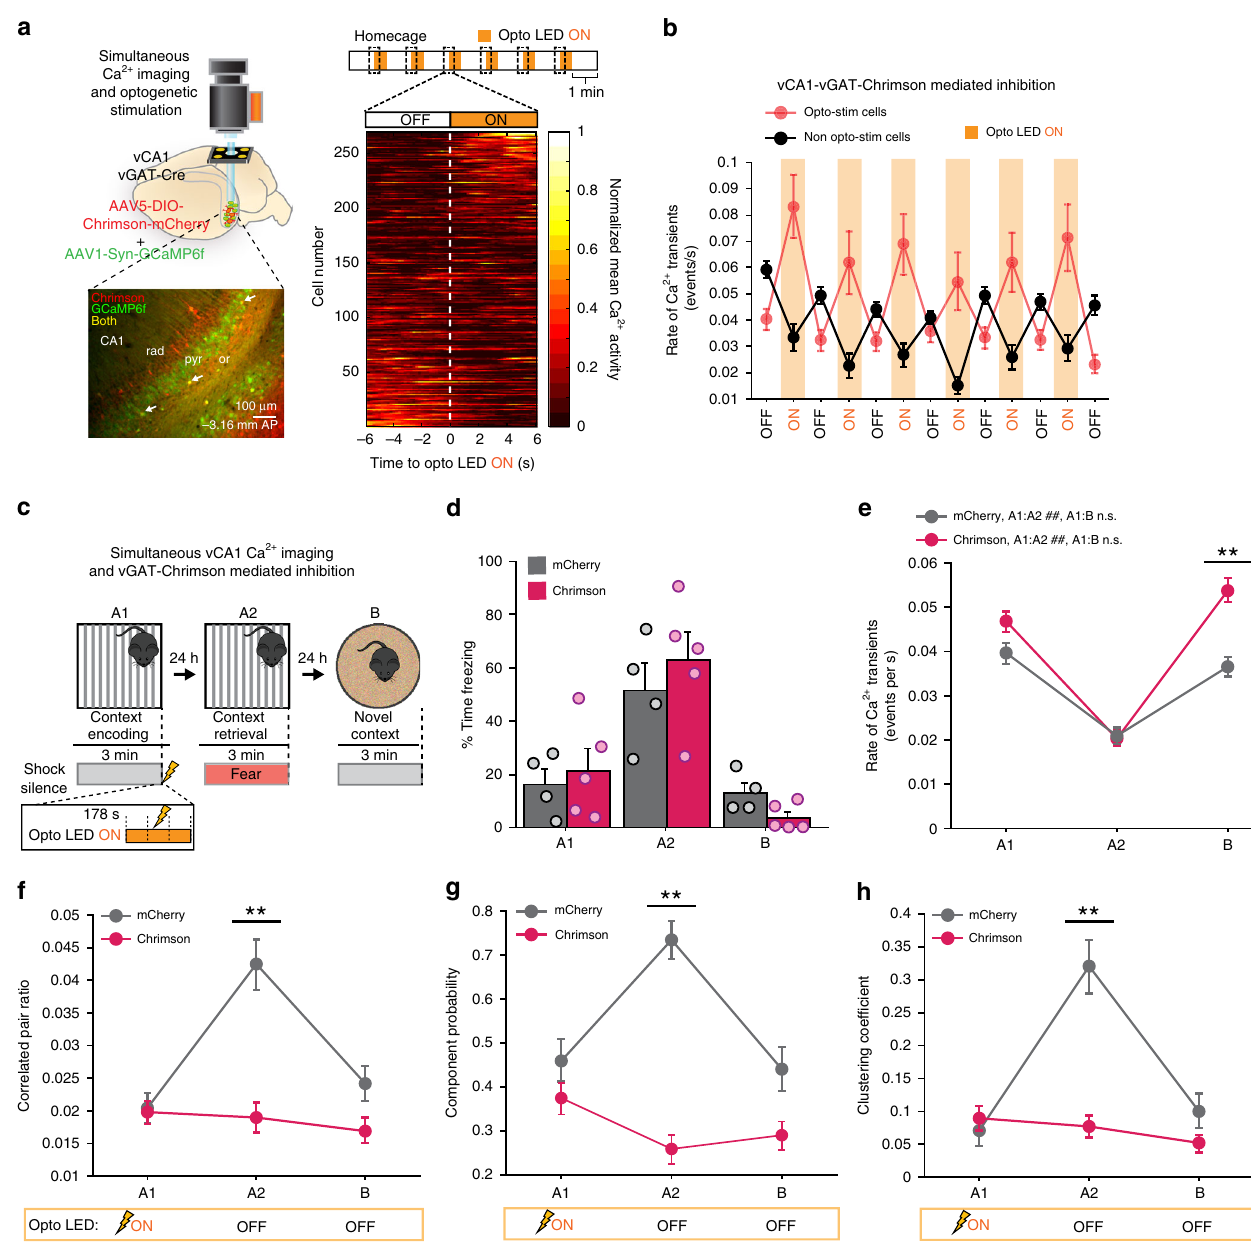
Fig. 4 vCA1 shock activity is necessary for correlated activity during memory retrieval. a Experimental design, simultaneous vCA1 Ca 2 + imaging and unilateral optogenetics. Top left: DIO-Chrimson and Syn-GCaMP6f were co-injected into vCA1 in vGAT-Cre mice to selectively express Chrimson in vGAT interneurons and GCaMP6f in all neurons. GCaMP6f was excited by a blue LED (455 nm). Chrimson was excited by an amber LED (590 nm). Bottom left: Representative image of vCA1 with co-expression of Chrimson (red), GCaMP6f (green), and cells expressing both (yellow) indicated by white arrow. Right: Heat map of Ca 2 + activity 6 s before and after turning on the optoLED (average of six pulses in homecage, cells sorted by magnitude of change ON – OFF). The main effect of this experiment was replicated in an independent dataset within the lab. b Rate of Ca 2 + transients in homecage during optoLED 6-s pulses ON in opto-stim (red) and non-opto-stim (black) cell populations demonstrating optogenetic silencing of vCA1 using vGAT-Chrimson activation. c Experimental design, mice were imaged in a 3-day contextual fear paradigm, with the optoLED turned ON during the footshock in A1 (ON from 178 to 184 s) to selectively disrupt the vCA1 shock response. d Unilateral shock silencing in A1 did not disrupt freezing behavior during retrieval (repeated- measures ANOVA; % time freezing*genotype interaction F (1,7) = 1.22, p = 0.33, N mCherry = 4, N Chrimson = 5). e vCA1-mCherry and vCA1-Chrimson neurons exhibited a similar decrease in Ca 2 + event rate during context retrieval (mCherry N cells = 102, Chrimson N cells = 190; Mann – Whitney between groups with Bonferroni corrected alpha: A1 U = 8636.00, p = 0.13, A2 U = 8907.00, p = 0.26, B U = 7071.00, ** p = 0.0001| Wilcoxon sign rank with